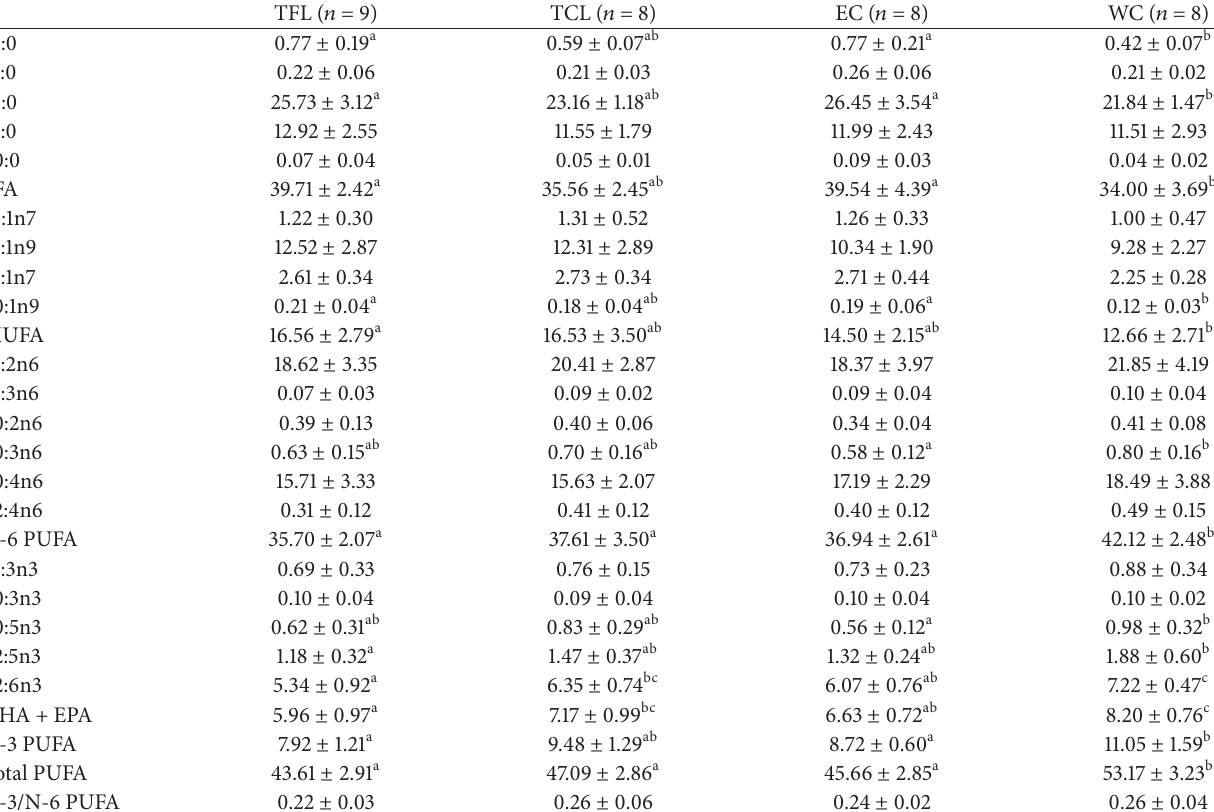
Table 6: Hepatic total fatty acid profiles after consumption of TFL and